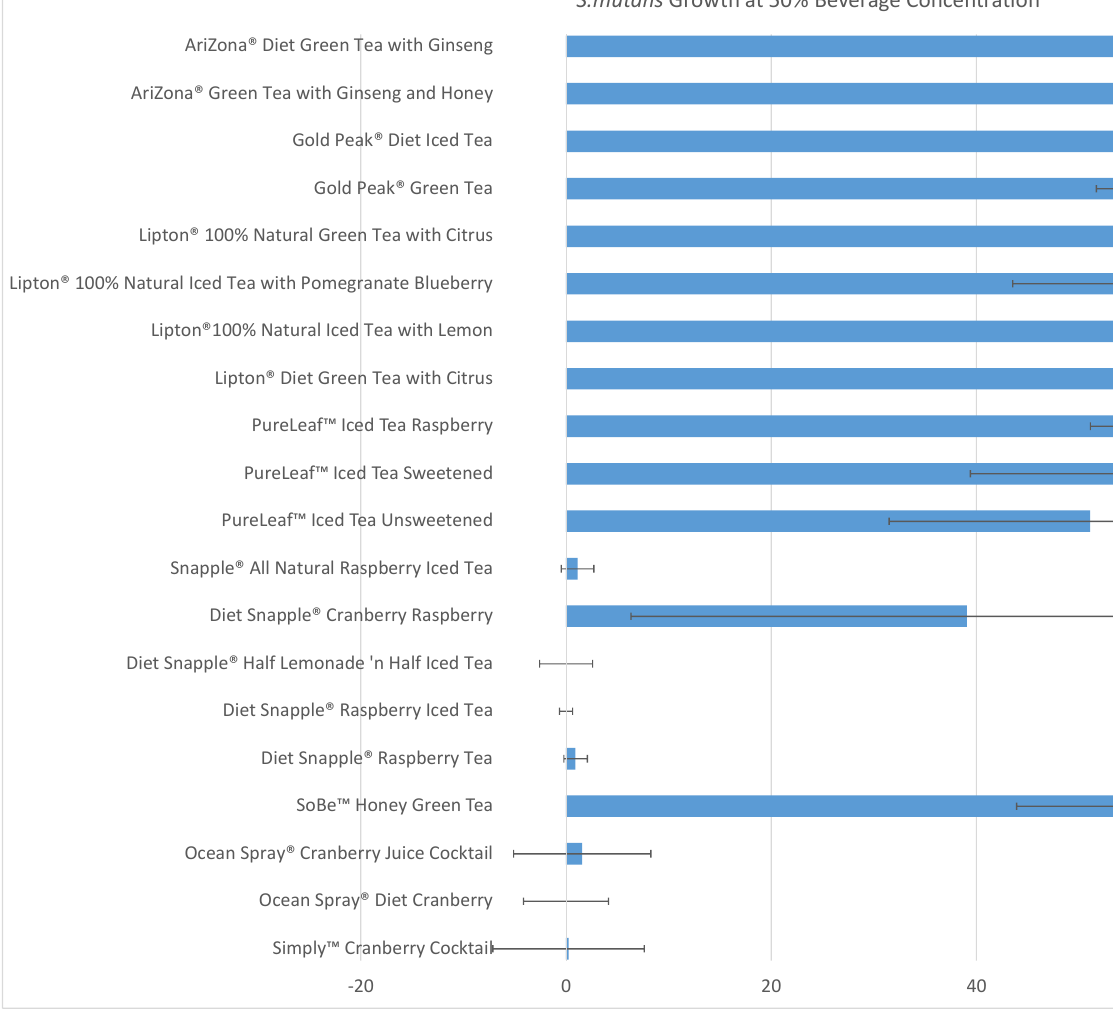
Figure 1. Growth of S. mutans in the presence of RTD bottled teas and beverages. * Growth expressed as % Growth = OD treated /OD control ×